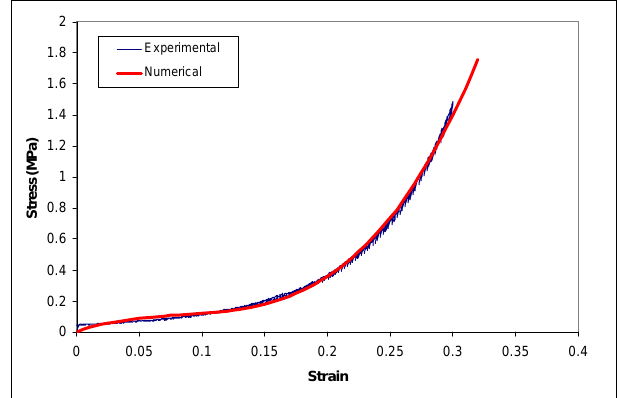
Fig 9: Normal stress vs normal strain